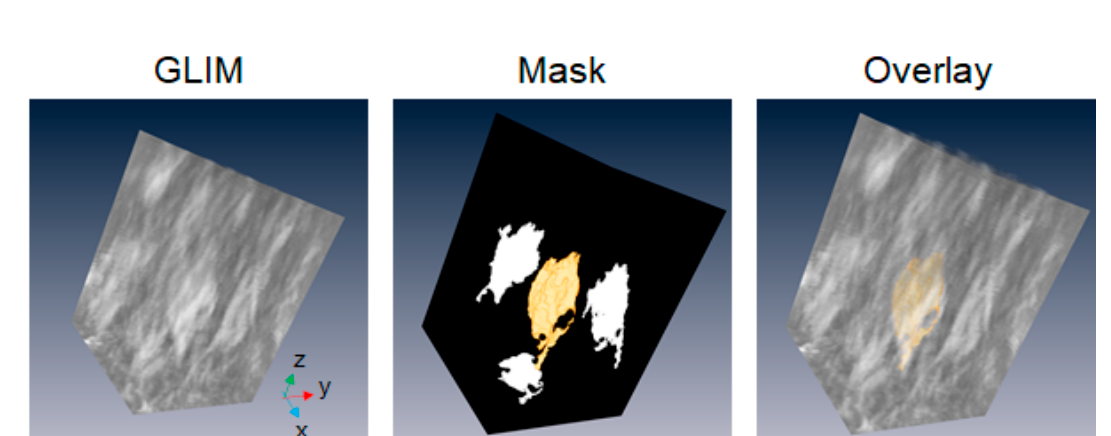
Figure 5. Sulforhodamine 101 enables identification of cells imaged by GLIM as astrocytes. ( a ) Live brain slices were incubated in ACSF containing 1 μ m Sulforhodamine 101 (SR101). SR101-pos-